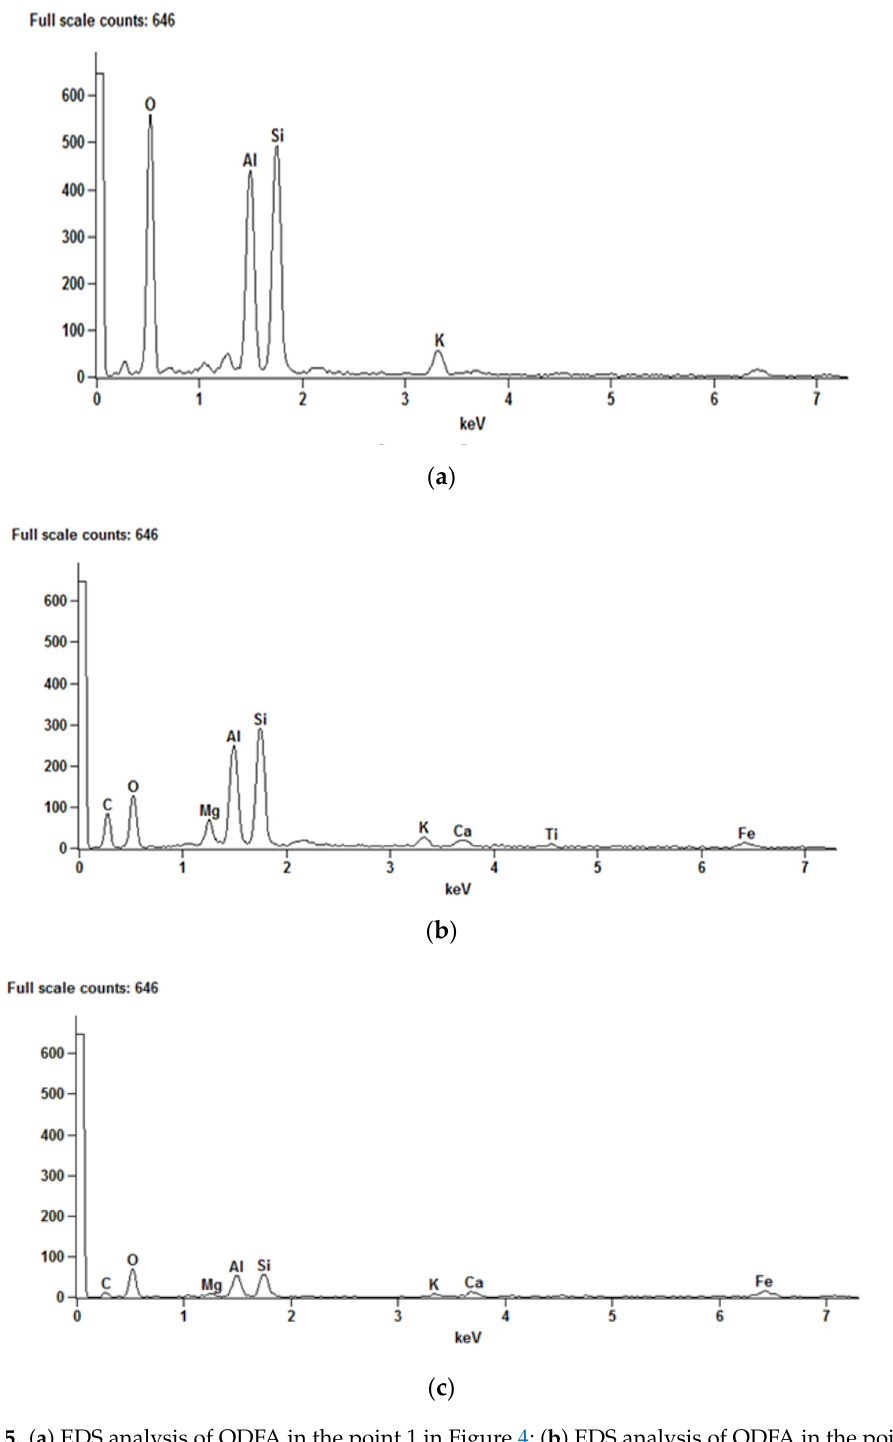
Figure 5. ( a ) EDS analysis of ODFA in the point 1 in Figure 4; ( b ) EDS analysis of ODFA in the point 2 in Figure 4; ( c ) EDS analysis of ODFA in the point 2 in Figure 4.